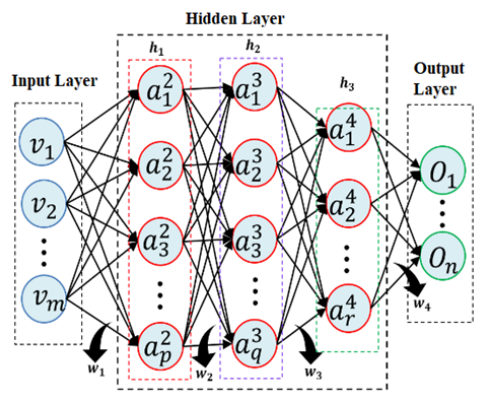
Figure 7. A DNN with three hidden layers